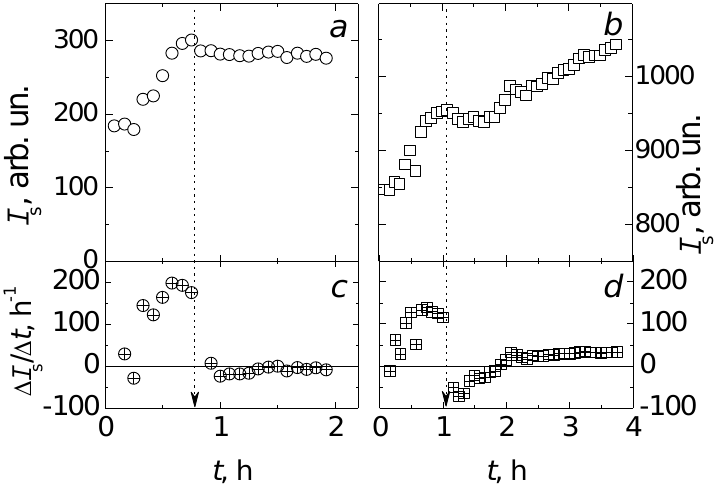
Figure 8. Effect of ceftriaxone on E. coli fission in nutrient broth for samples No. 3 and No. 4 with ceftriaxone concentrations: ( a )–0.84 mg/mL and ( b )–0.070 mg/mL, respectively. Dependences of laser light scattering intensity on time ( a , b ) and the slopes of these dependences ( c , d ). The arrows indicate the time of ceftriaxone injection in samples.